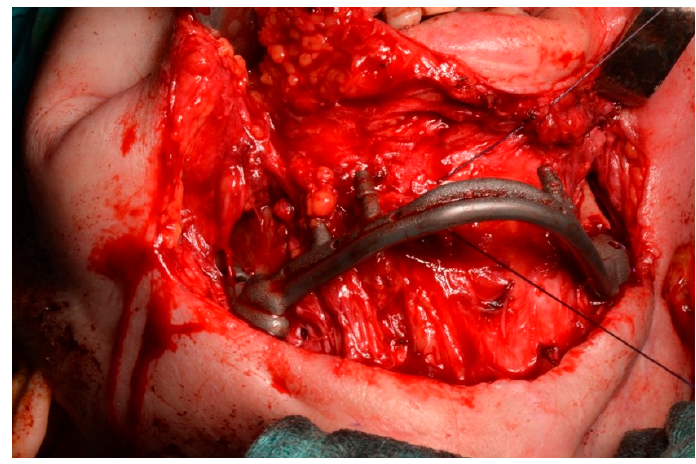
Figure 10. The mandibular prosthesis connected to the residual branches by osteosynthesis screws.